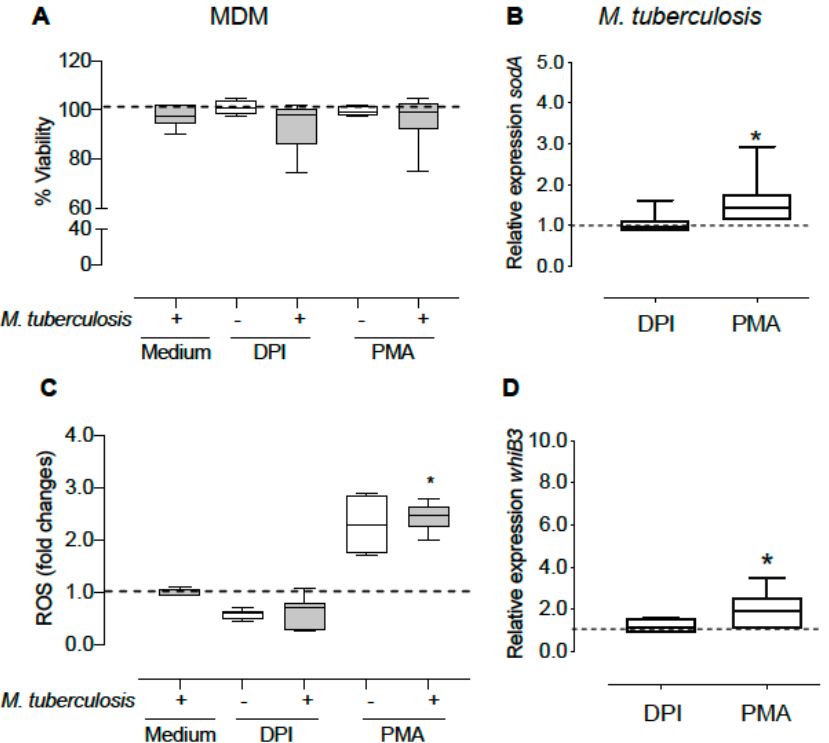
Figure 2. Effect of NOX activity modulation on gene expression of intracellular mycobacteria. The macrophages were treated with PMA (750 ng/mL) or DPI (20 µM) for 1 h. Subsequently, they were infected with M. tuberculosis (MOI 1:15) in the presence of PMA or DPI and incubated for another hour. The non-phagocytized bacteria were eliminated and fresh medium with PMA or DPI was added for 2 more hours. We detected cell viability ( A ) and ROS levels ( C ) in MDM. Furthermore, expression levels of whiB3 and sodA ( B , D ) were determined in intracellular bacteria. The data show the maximums and minimums by quartiles. * p < 0.05 significant difference compared to the expression of uninfected macrophages ( A , C ) or intracellular bacteria without treatment ( B , D ), n = 4–7. The Wilcoxon test was used to compare to the control. In panels ( A , C ), the dashed horizontal line represents the median of the uninfected macrophages without treatment, and panels ( B , D ), represents the median of the intracellular bacteria without treatment.